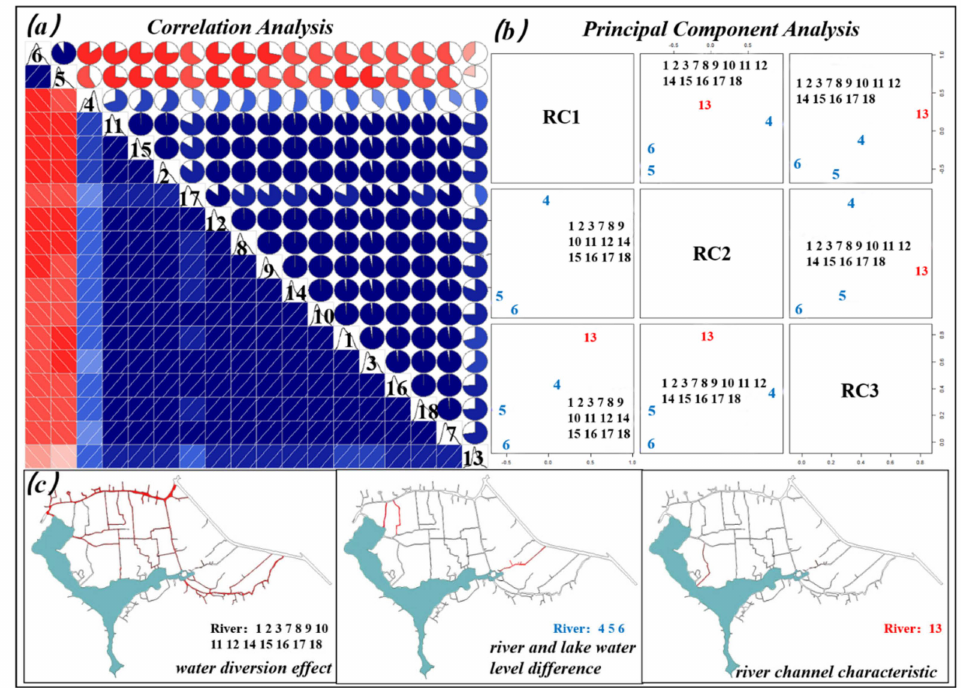
Figure 8. ( a ) Flow velocity correlation of 18 rivers under 10 water diversion schemes; ( b ) Prin- cipal component analysis; ( c ) Spatial distribution of three types of rivers based on principal component